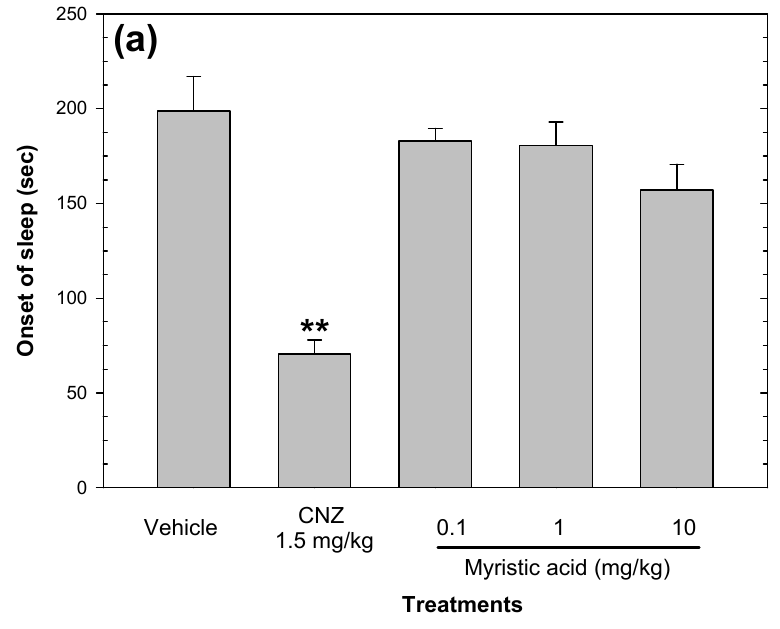
Figure 9 . Anxiolytic-like effects of myristic acid (0.1–10 mg/kg p.o.) were measured in the cylinder exploratory test ( a ) and the hole-board test ( b ) during a 5 min exposure. The possible mechanism of action of myristic acid was evaluated in the cylinder exploratory test ( c ) and the hole-board test ( d ). Clonazepam (CNZ) at 1.5 mg/kg p.o. was used as the positive control. Bars represent mean values (± SEM) for the experimental group. n = 8, ** p < 0.05 compared to the vehicle group.